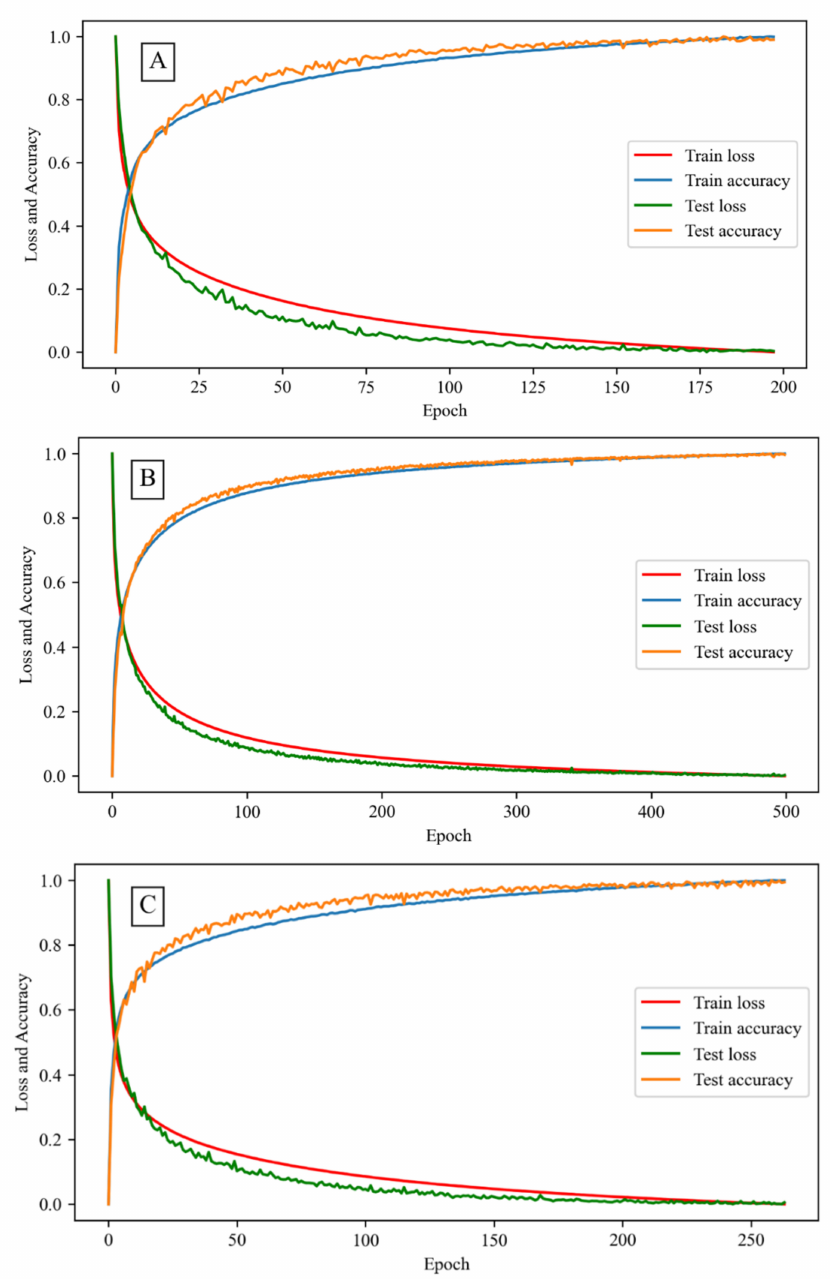
Figure 9. The loss and accuracy curve of proposed DNN for SGD classification using a combination of remote-sensing data. ( A ) Optical-SAR-TIR-S; blue, green, red, NIR, SWIR, coherence, and slope, ( B ) Optical-TIR-S-E; blue, green, red, NIR, SWIR, and slope, ( C ) Optical-SAR-TIR; blue, green, red, NIR, SWIR, SAR, and